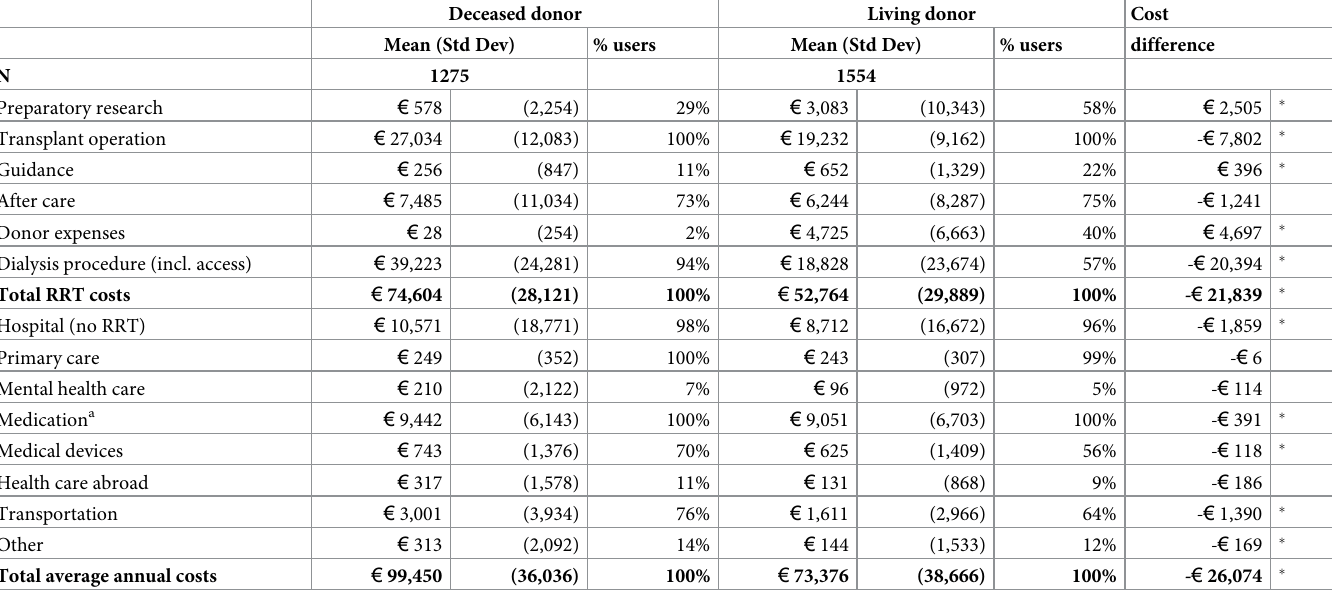
Table 5. Total average annual costs of transplantation (year 0) by source of kidney donor ( €